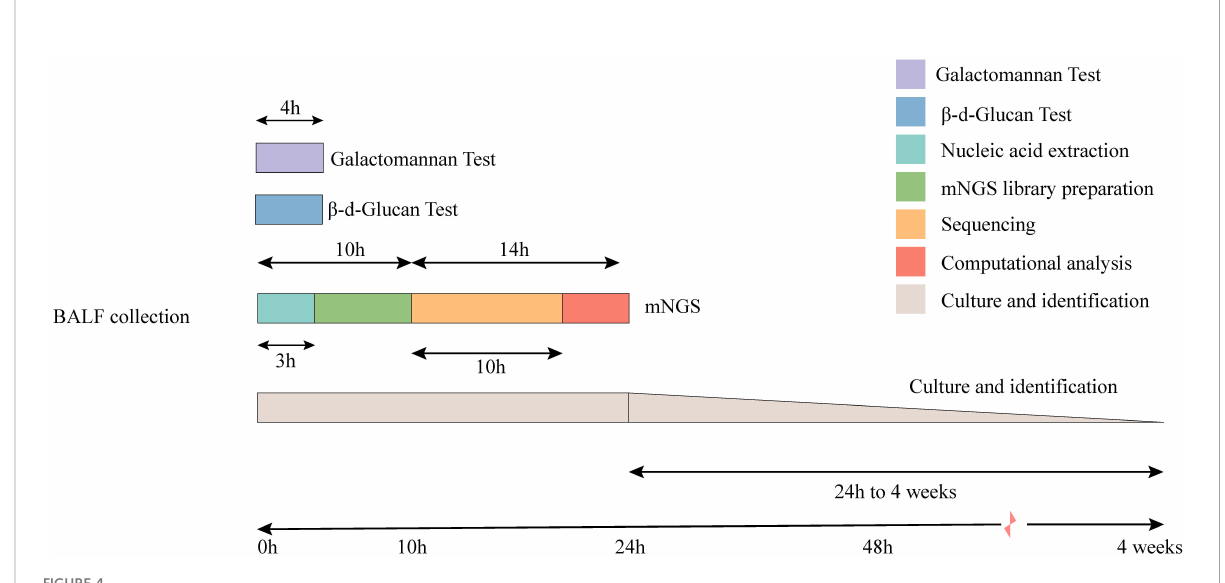
FIGURE 4 Timeline for mNGS and CMTs. Culture-based pathogen identi fi cation can take days to weeks. In comparison, mNGS testing using the BGI sequencing platforms has an overall turnaround time of 24